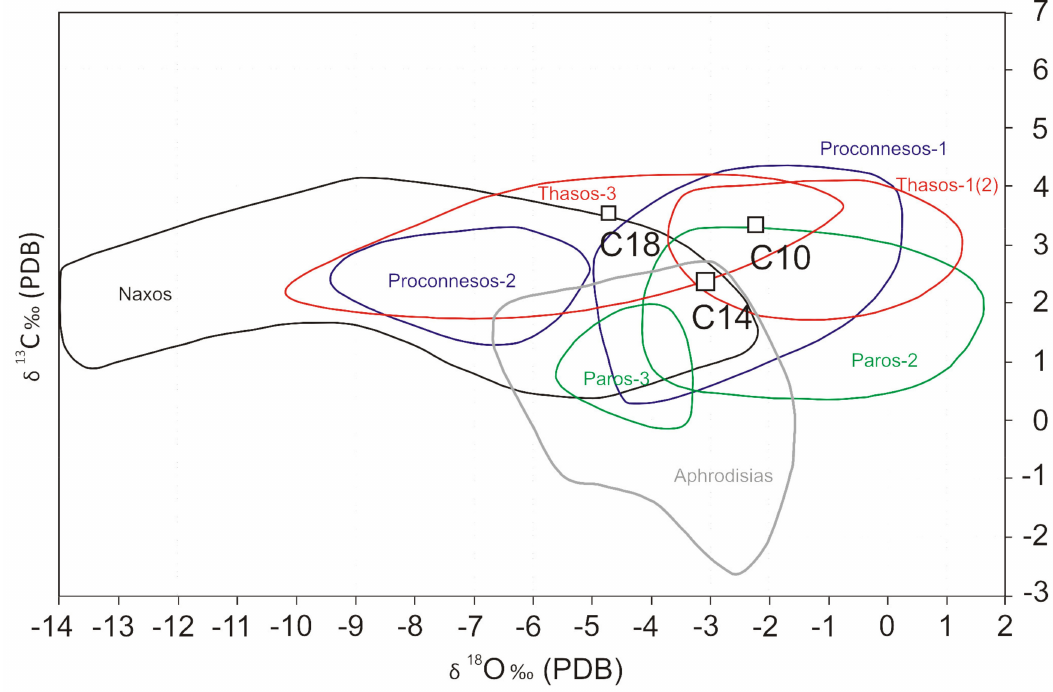
Figure 6. Comparison of the isotopic signatures of the marbles coming from Tauriana with the data for medium- to coarse-grained marbles used in antiquity